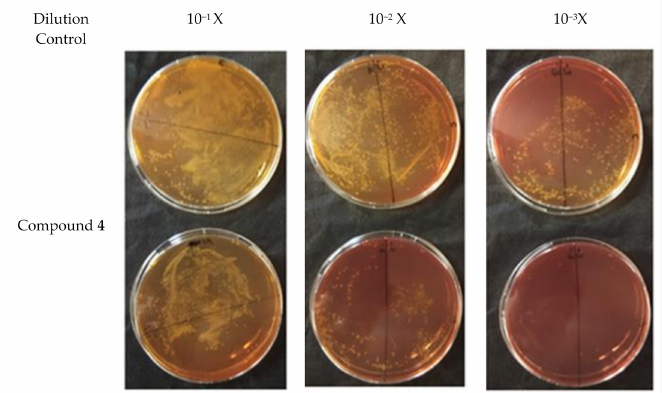
Figure3. Resultoftheplateconjugationassayshowingthetransconjugantcellsfor 4 withaconcentration of a quarter of MIC and control using plasmid pKM101 in E. coli .